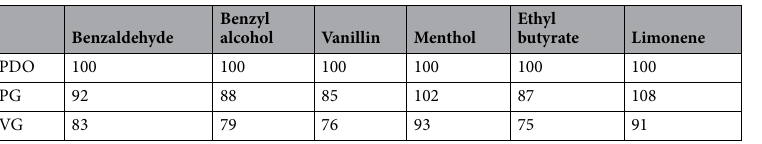
Table 3. Relative solvation free energies for the selected couple of e-liquids and flavors, normalize to 100 for